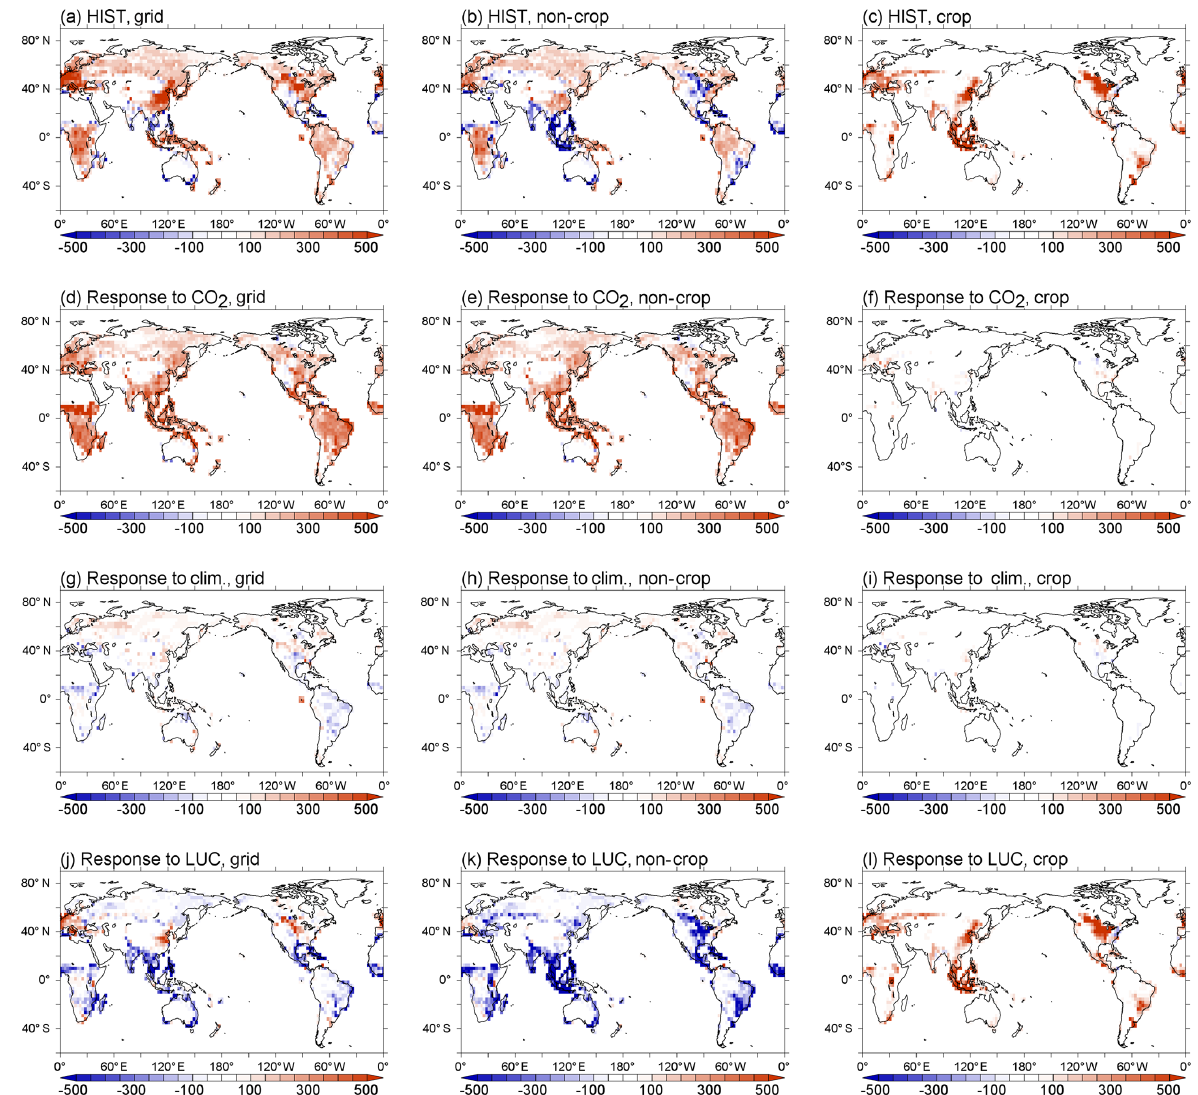
Figure 13. (a, b, c) Changes in GPP (gCm − 2 yr − 1 ) in HIST derived by taking the difference of the 2005–2014 averages of GPP between HIST and CTL. (d, e, f) GPP response to CO 2 increase diagnosed from simulation results of HIST, HIST-NOLUC, and HIST-BGC. (g, h, i) GPP response to climate change diagnosed by taking the difference between the simulation results of HIST and HIST-BGC. (j, k, l) GPP response to LUC obtained by taking the difference between HIST and HIST-NOLUC. GPP changes in each left-hand panel are further decomposed into contributions from (middle panels) non-crop tiles (primary vegetation, secondary vegetation, urban areas, and pasture) and (right-hand panels) crop